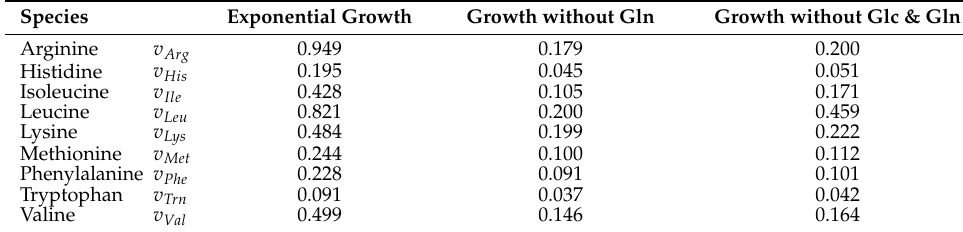
Table 3. Specific uptake rates ( µ M/d × 10 7 cell) for essential AA.